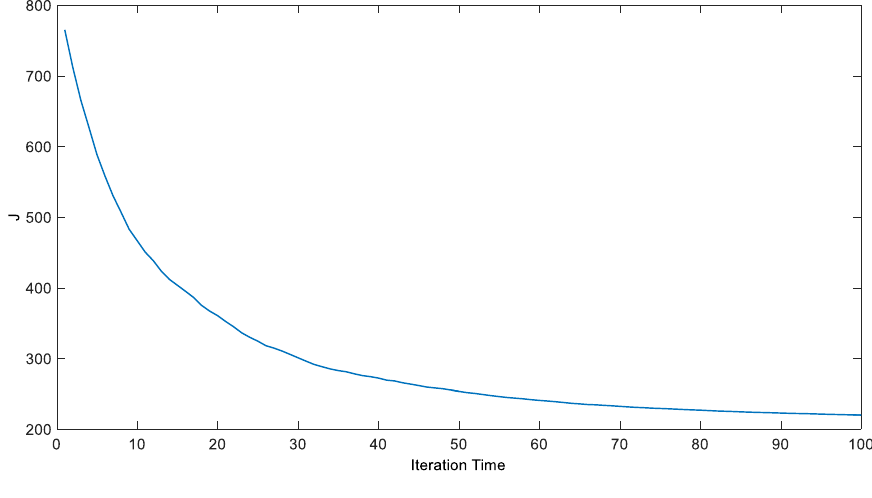
Figure 9. The trend line of the judgment value.